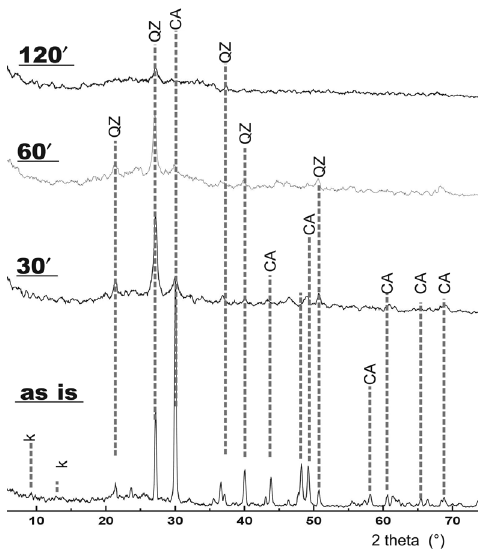
Fig. 6. XRD analysis of treated samples at different main grinding time phases: QZ – quartz; k – kaolinite; CA –